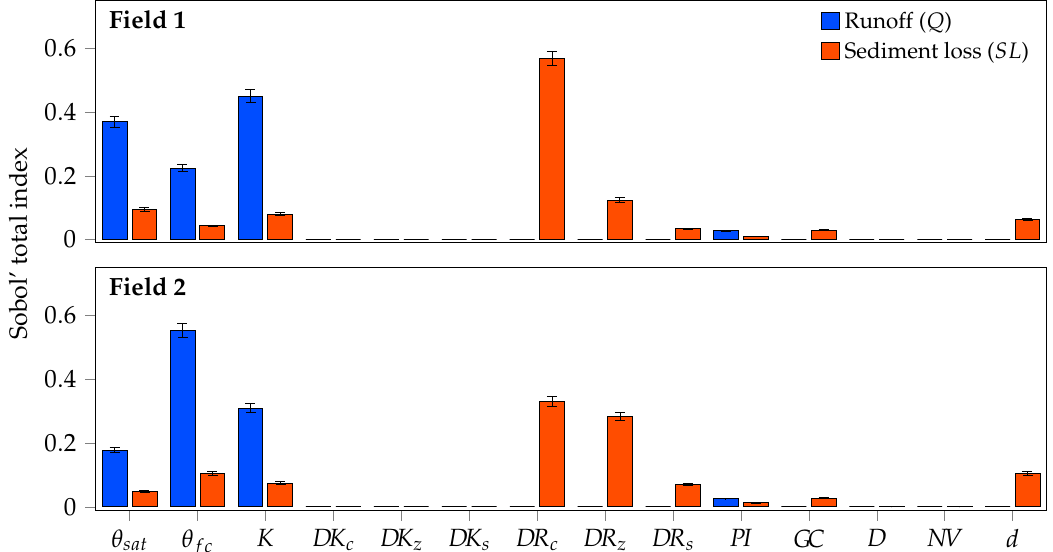
Figure 6. Sobol’ total indices for runoff ( Q ) and sediment loss ( SL ) of the two field sites. Bars indicate the Sobol’ total indices and the error bars indicate the 95% confidence intervals of the indices from bootstrapping. We checked the sensitivity of the model to the parameters with high uncertainty due to absence of field data, such as parameters related to soil detachability (i.e., DK c , DK z , DK s , DR c , DR z , and DR s ), soil hydraulic parameters (i.e., K , θ sat , and θ fc ), vegetation structural parameters (i.e., GC , D , NV ), the permanent interception ( PI ), and the rill depth ( d ). K , θ sat and θ fc showed relatively high impacts on the runoff ( Q ) and the sediment loss ( SL ). The sediment loss ( SL ) also showed high sensitivity to DR c , DR z , DR s and d